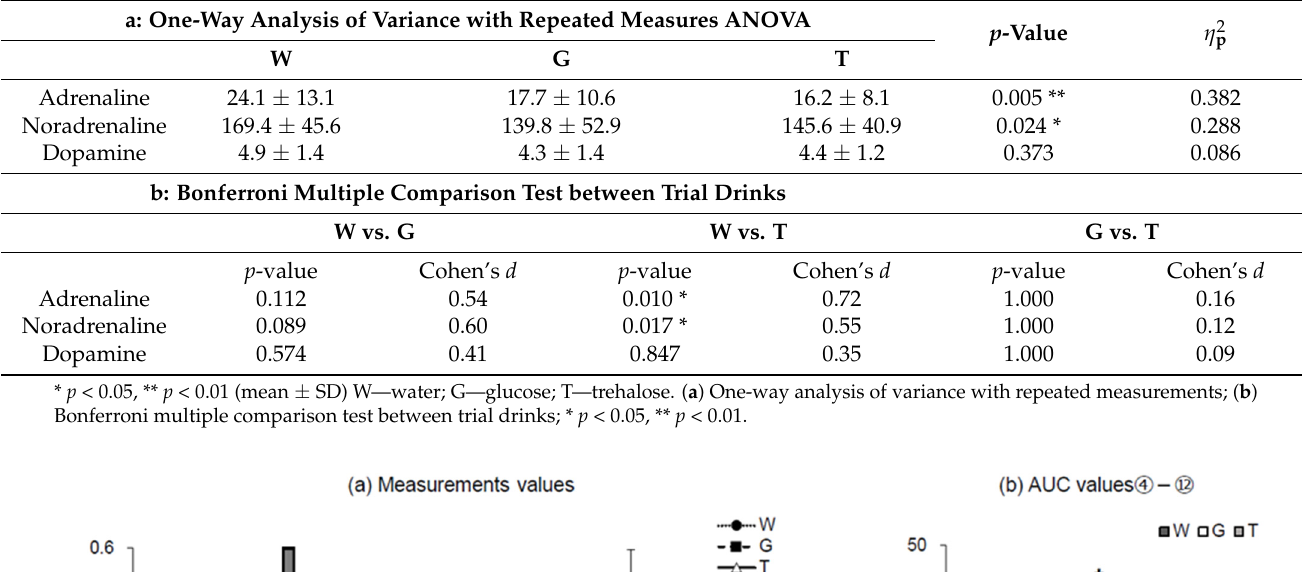
Table 3. Statistical results for catecholamine AUC